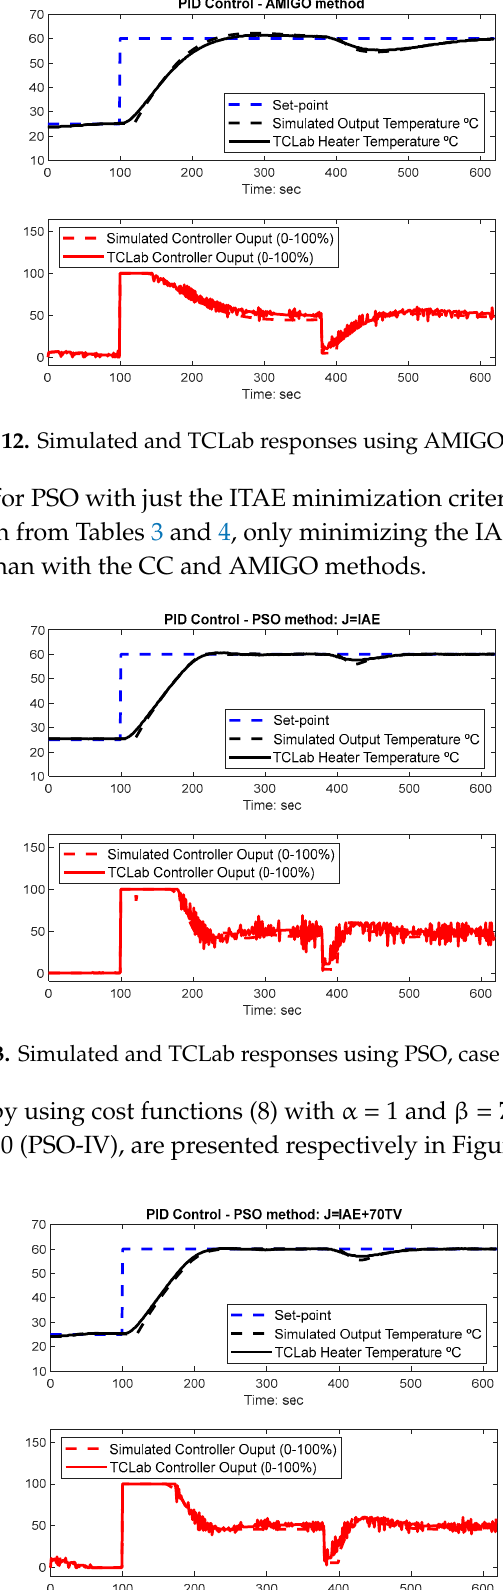
Figure 14. Simulated and TCLab responses using PSO, case II (J = IAE + 70 TV).